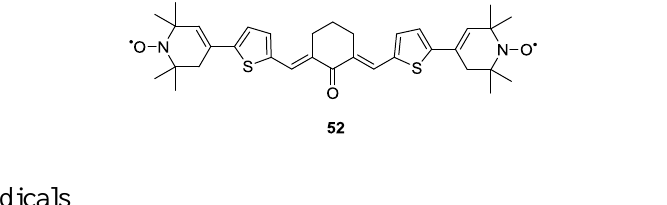
Figure 7. Structure of biradical used for calibration of DQC